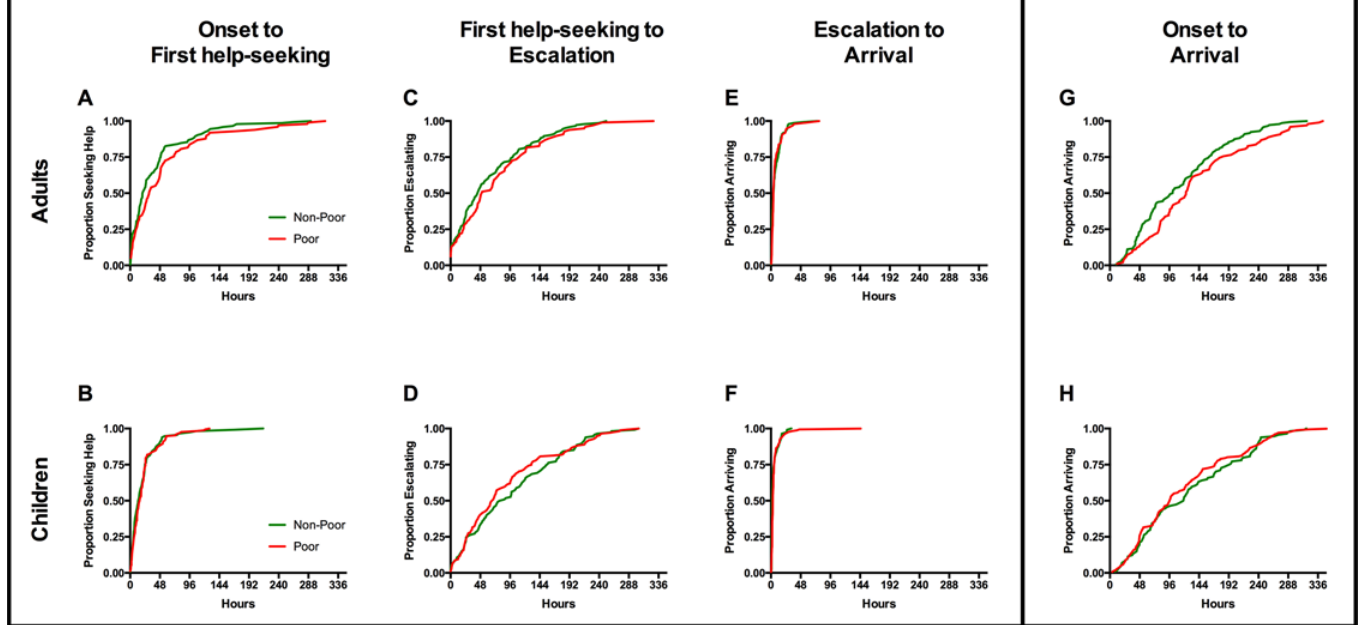
Fig 4. Cumulative histograms of time to key stages in care-seeking. The total timespan from onset of symptoms to arrival at the referral hospital is subdivided into three stages: (A, B) time until the first decision to seek help outside the home; (C, D) time from this decision until escalation to a referral hospital; (E, F) time from the decision to escalate until arrival. Panels G and H represent the cumulative timecourse of all three stages for adults and children respectively.